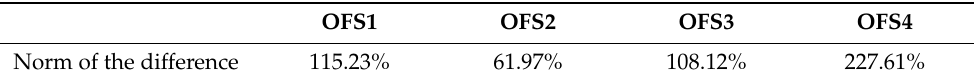
Figure 9. Responses of the φ -OTDR sensor with the plate in rest conditions (blue curves) or cantilever conditions (red curves). Table 2. Norm of the difference between the φ -OTDR signals acquired with the plate in rest conditions or cantilever condition.